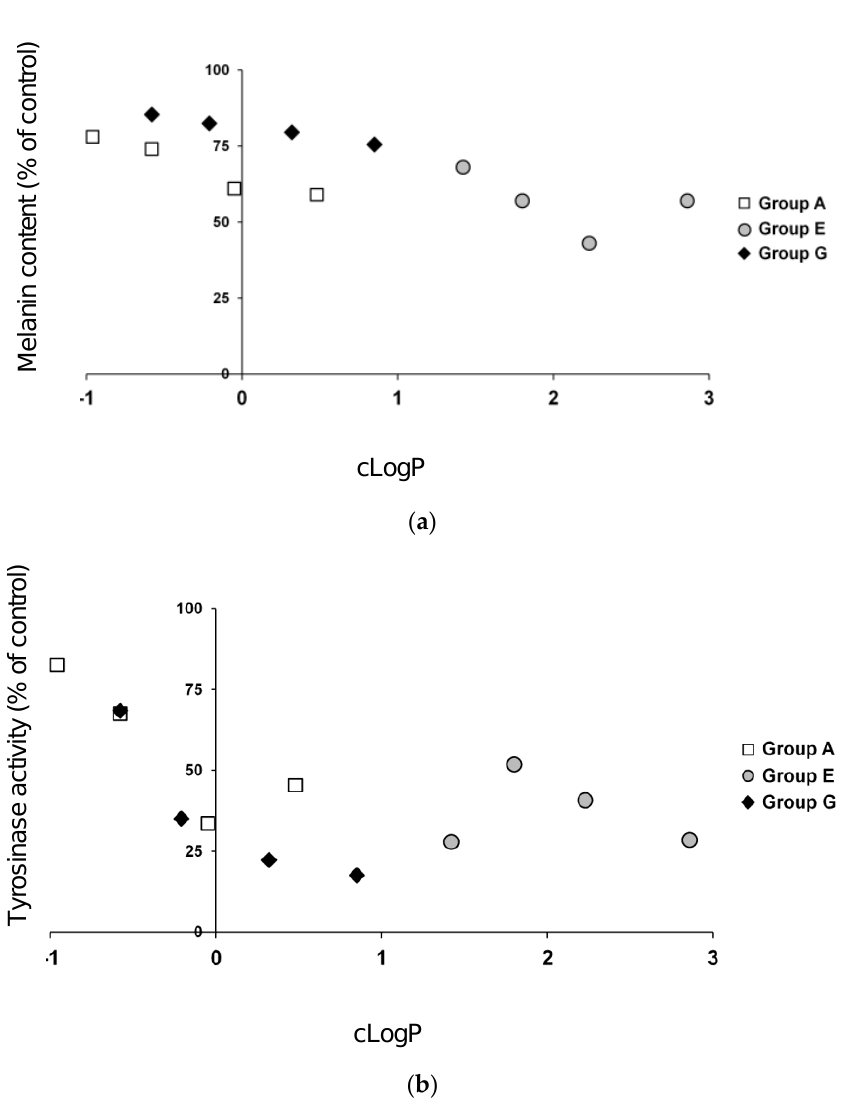
Figure 3. Correlation between cLogP versus melanin content and tyrosinase activity. Melanin content ( a ), tyrosinase activity ( b ).